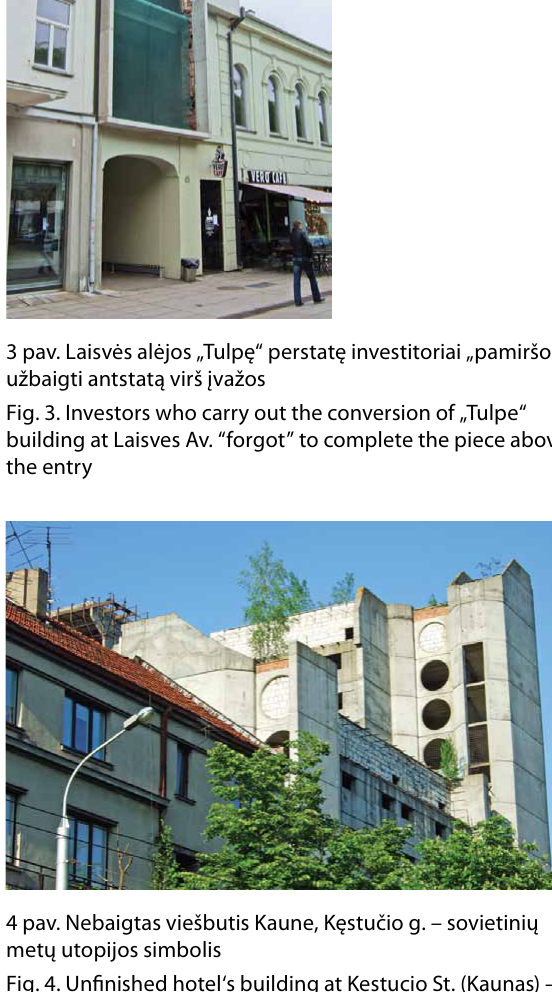
fig. 4. unfinished hotel‘s building at Kestucio St. (Kaunas) – the emblem of the Soviets